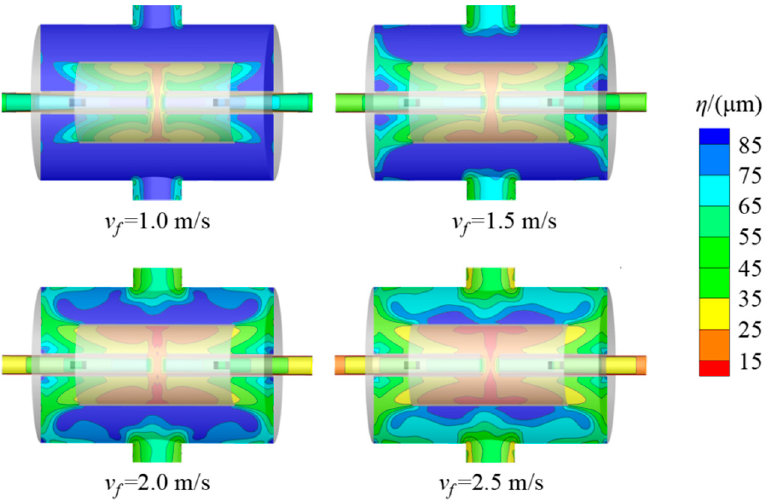
Figure 7. Kolmogorov scale distributions of the CFPCD for different feeding velocities.